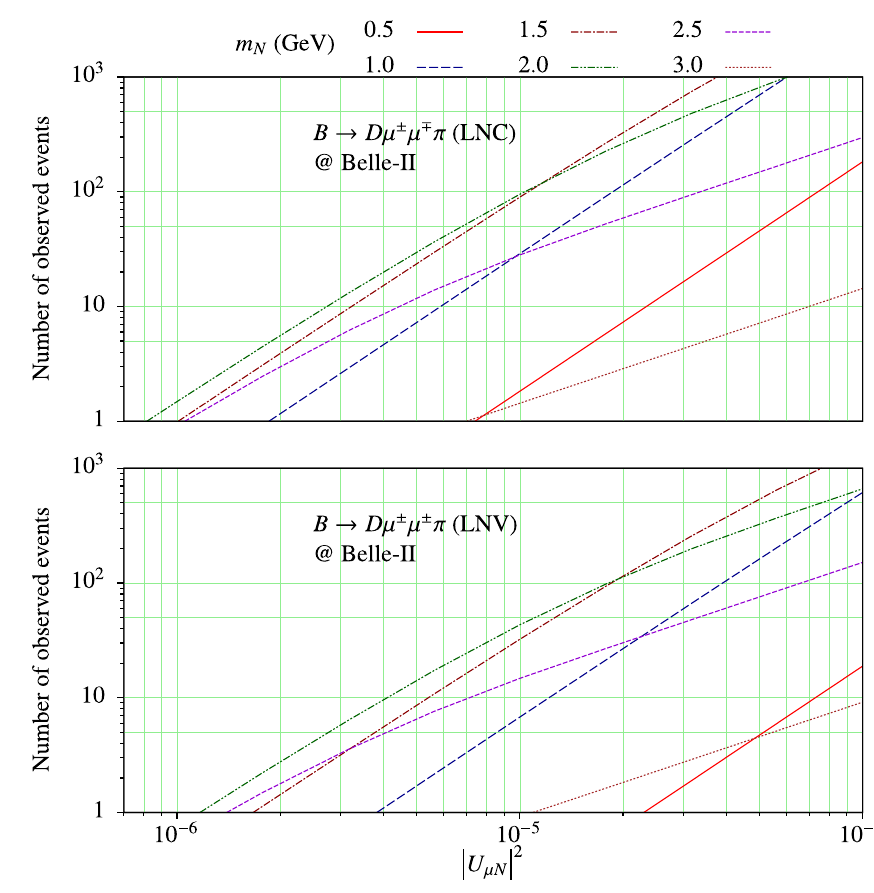
Fig. 6 Numerical study of feasibility of observing Dirac (LNC) signal B → D μ ± μ ∓ π and Majorana (LNV) signal B → D μ ± μ ± π , inside Belle II detector with decay lengths less than 1 m. Here we have neglected the contributions from both | U eN | 2 and | U τ N | 2 when compared with | U μ N |